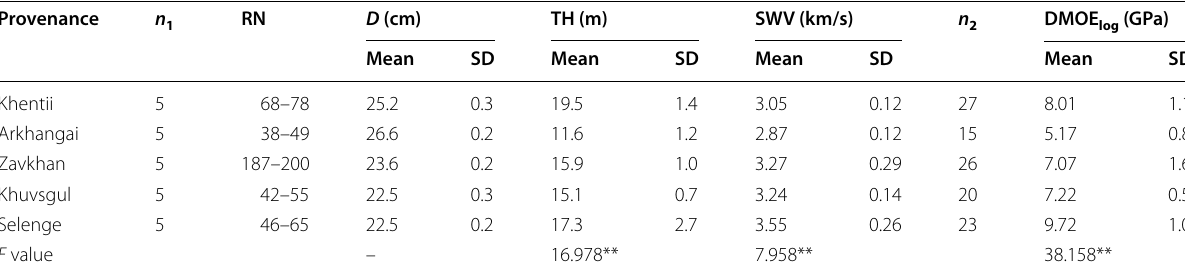
n 1 : number of harvested trees; n 2 : number of logs; RN: annual ring number at 1.3 m above the ground, D : stem diameter at 1.3 m above the ground; TH: tree height; SWV: stress-wave velocity of stem; DMOE log : dynamic Young’s modulus of logs **Significant difference among provenances ( p < 0.01). F values were obtained by analysis of variance (ANOVA) test